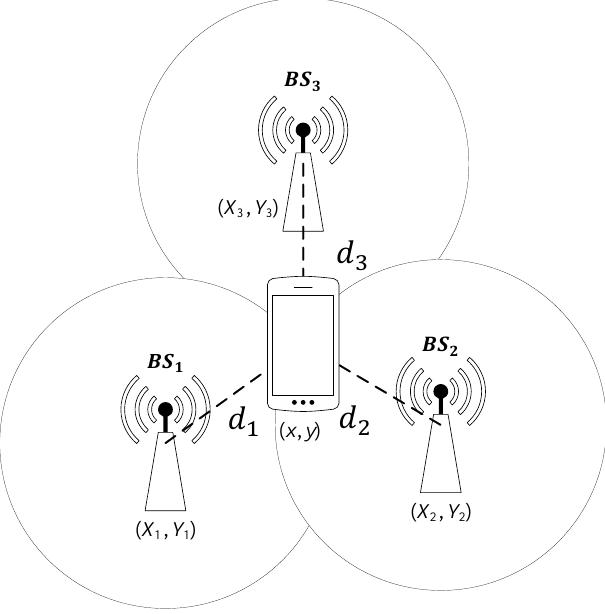
Figure 2. The Time of Arrival (ToA) scheme.